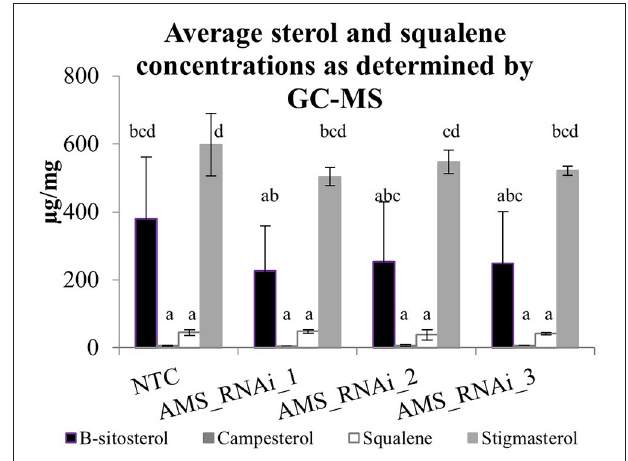
FIGURE 7 | Average peak area from GC-MS for squalene and sterol compounds identified from dried pooled leaf material for NTC and AMS silenced lines. Error bars ± SD (NTC— n = 6, AMS _RNAi lines— n = 3). Letters represent Bonferroni test results after ANOVA, groups not sharing letters indicate statistically significant differences ( p ≤